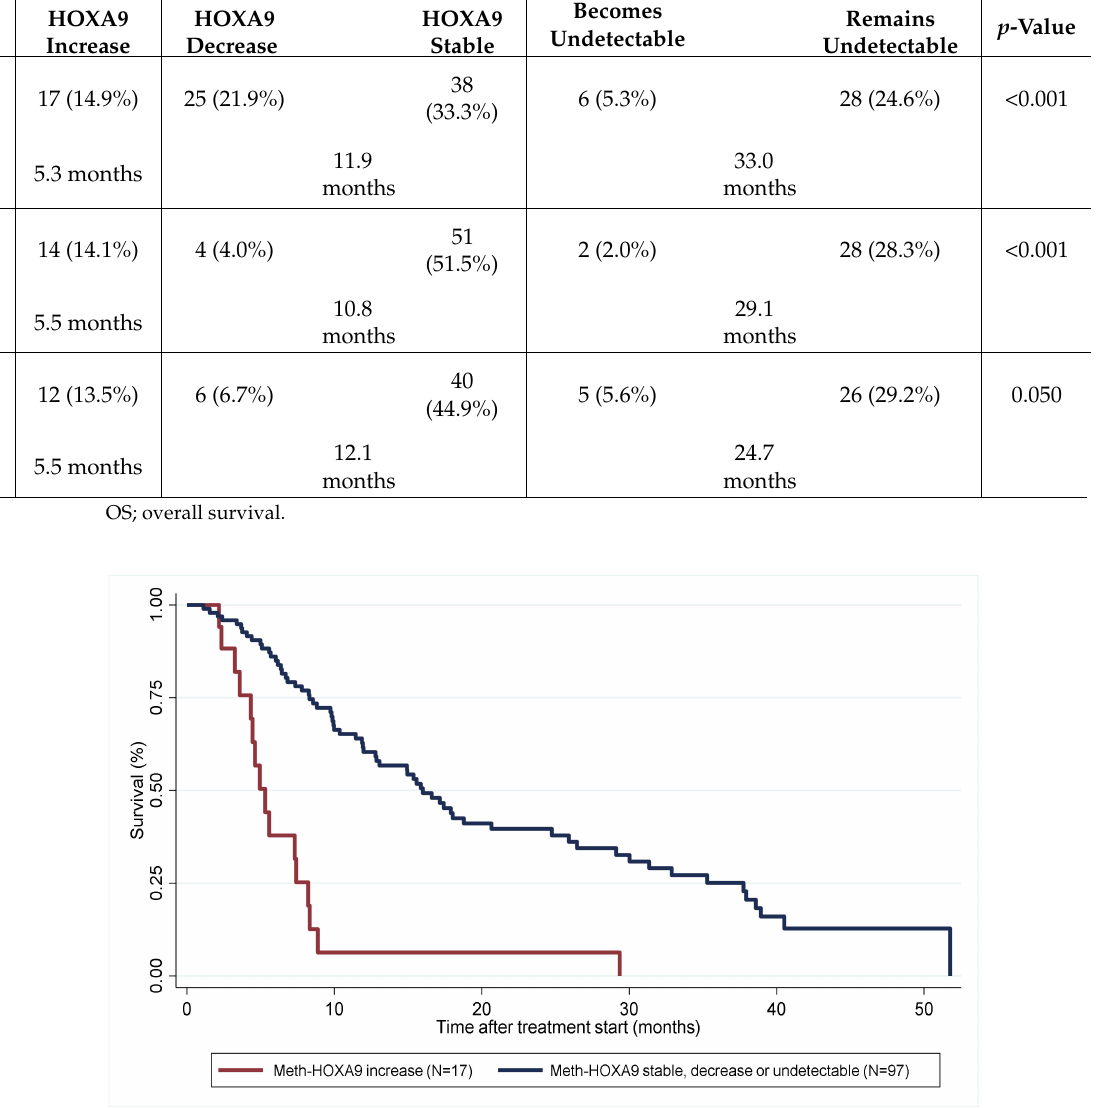
Figure 2. Kaplan-Meier plot illustrating overall survival for patients with an increase in meth- HOXA9 (red, n = 17) vs. patients with stable, decreasing or undetectable meth- HOXA9 (blue, n = 97) after one treatment cycle